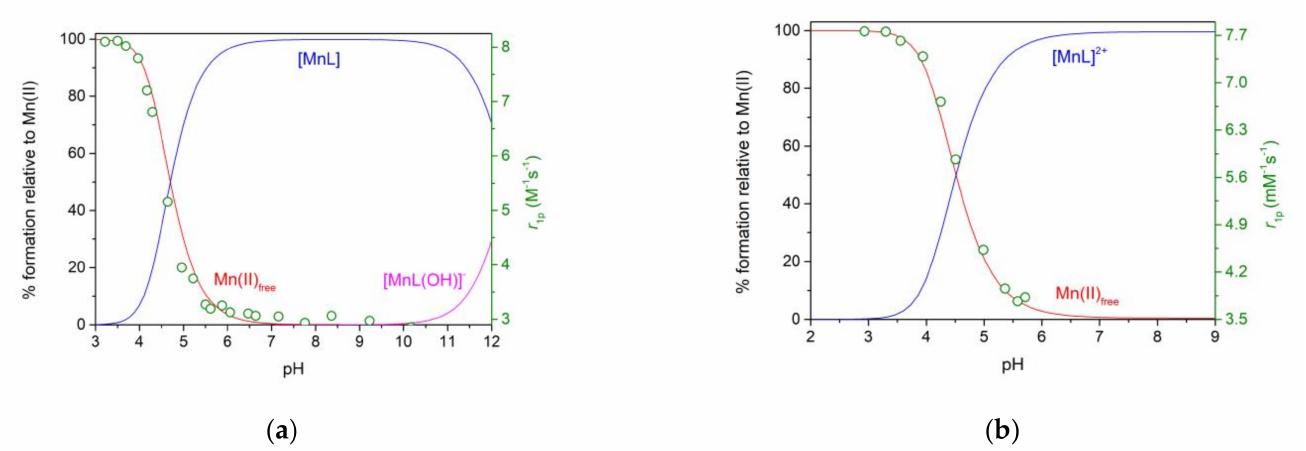
Figure 2. Species distribution diagrams of the Mn(II) − L − H + systems ([Mn(II)] = [L] = 1.0 mM, solid lines, L = t O2DO2A 2 − ( a ) or t O2DO2AM Pip ( b ) and the normalized r 1p relaxivity values obtained as function of pH at 20 MHz, T = 25 ◦ C and I = 0.15 M